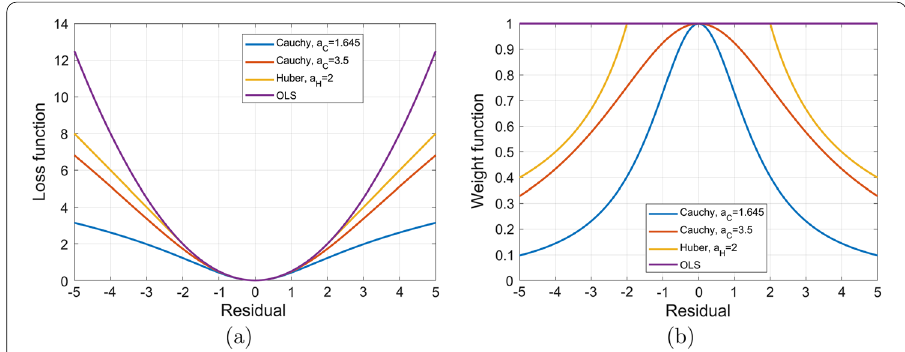
Fig. 2 OLS, Huber’s t and Cauchy M-estimators: a loss functions, b weight functions